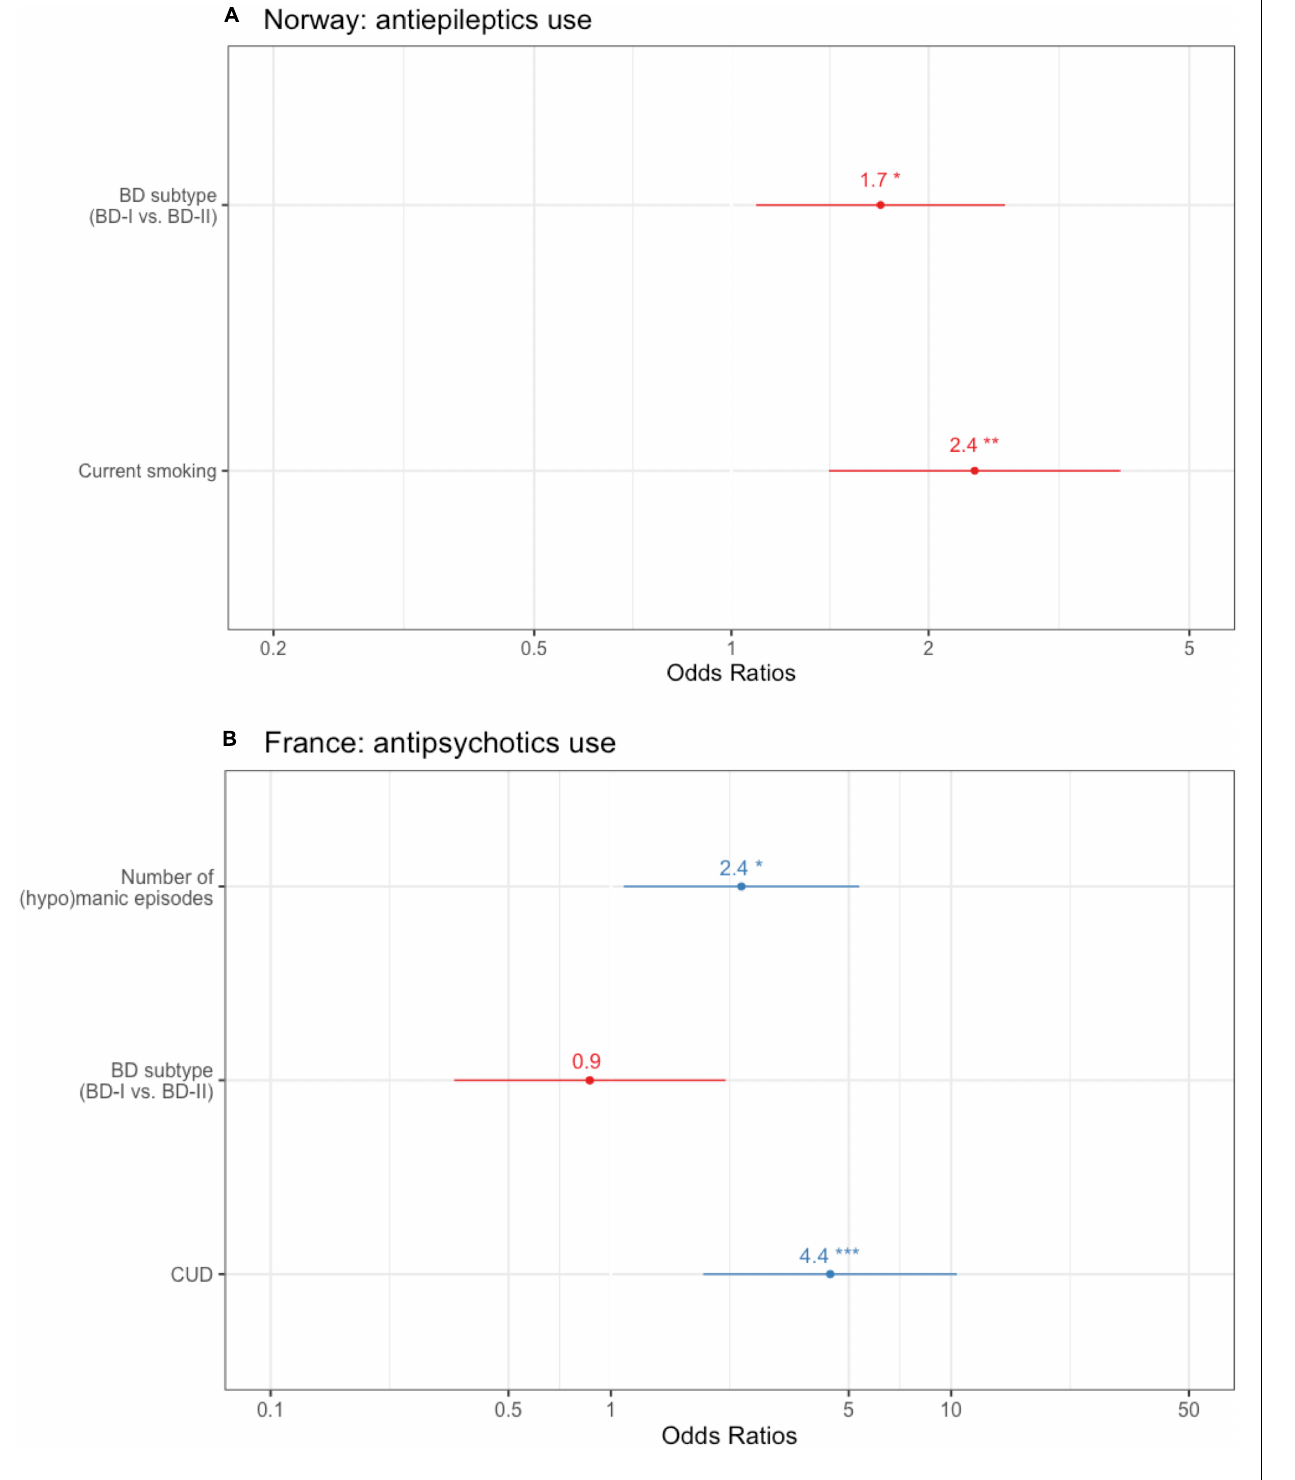
FIGURE 2 | Country-specific binary logistic regressions with (A) anti-epileptics use in the Norwegian subsample ( N = 425) and (B) antipsychotics use as the dependent variable in the French subsample ( N = 243; the SUD predictor of interest is CUD). Bar length indicates 95% confidence interval. AAO, age at onset; BD, bipolar disorder; CUD, cannabis use disorder. Other SUD refers to SUDs not related to alcohol, nor cannabis. * p < 0.05, ** p < 0.01, *** p < 0.001.